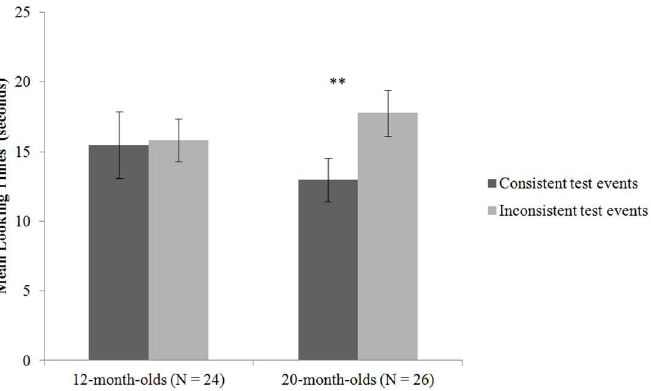
Fig 2. Infants’ mean looking times in the emotion-action understanding